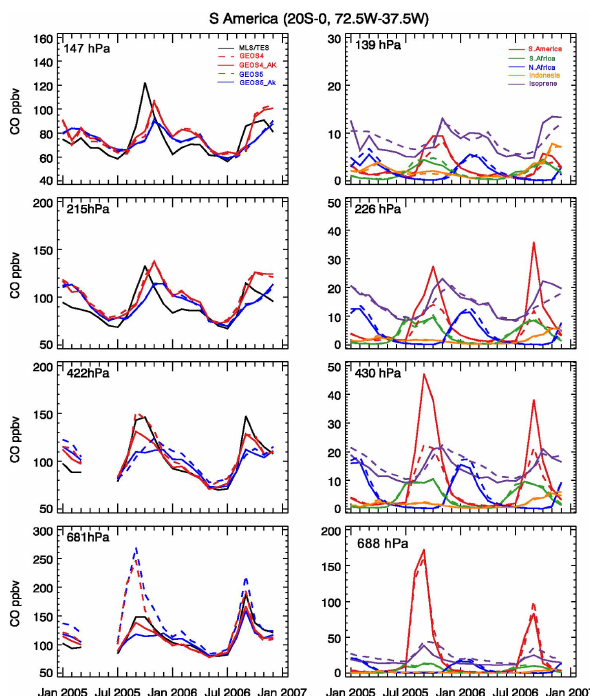
Fig. 8. Left: Time series of TES CO (681 and 422hPa) and MLS CO (215 and 147hPa) (black) and model results for GEOS-4 (red) and GEOS-5 (blue) over South America. The MLS CO values at 215hPa have been scaled by 0.5 and those at 147hPa by 0.7, based on the validation shown in Livesey et al. (2008). Solid lines show the model results with the AKs applied, dashed lines show the model results without the AKs. Right: Time series of tagged CO tracers over South America from individual sources: biomass burning in South America (red), southern Africa (green), northern Africa (blue) and Indonesia (orange), and the biogenic source from isoprene (purple). Results are shown for GEOS-4 (solid lines) and GEOS-5 (dashed lines) at model levels 688, 430, 226, and